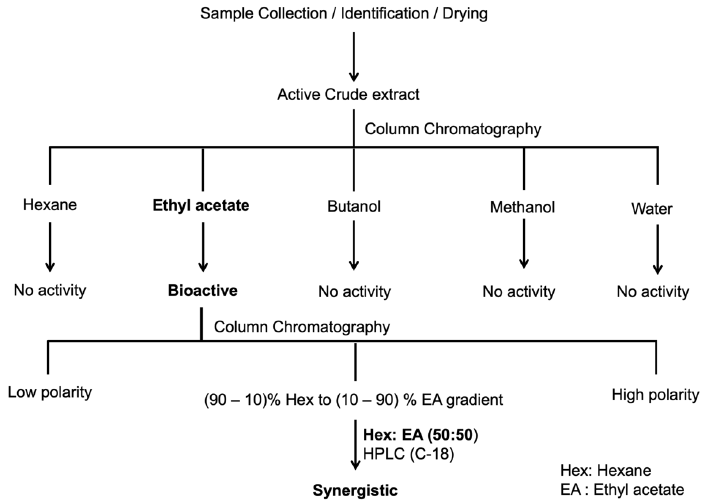
Figure 1. Flowchart depicting process of extraction and bioassay-guided purification of Zanthoxylum armatum DC leaf extracts. Successive extractions using different solvents of increasing polarity (hexane < ethyl acetate < butanol < methanol < water) to purify bioactive fractions. The extracts were subjected to fractionation using silica column chromatography and thin-layer chromatography (TLC).